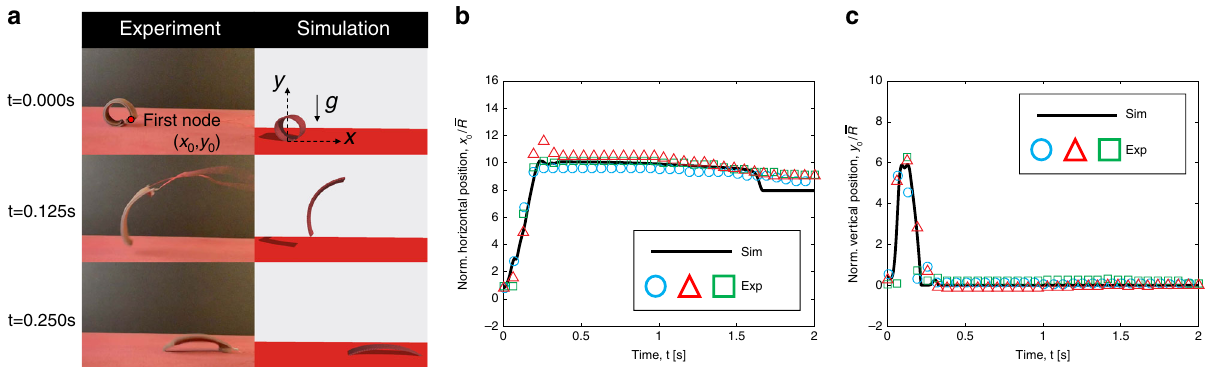
Fig. 7 Dynamics of the jumper robot. a Snapshots of the jumper robot from experiments and simulations at different time steps (Supplementary Movie 1). b Normalized x position of the fi rst node (marked in a ) in jumper robot as a function of time from experiments (symbols) and simulations (solid lines). c Normalized y position of the fi rst node (marked in a ) in jumper robot as a function of time from experiments (symbols) and simulations (solid